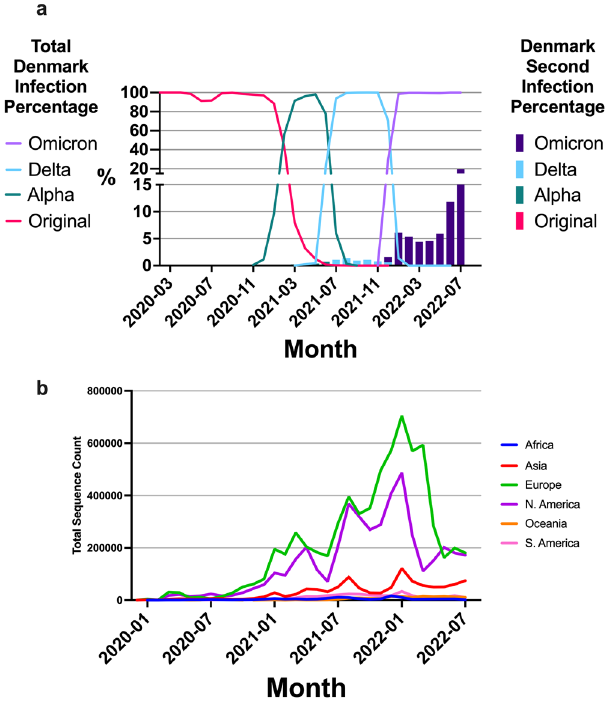
Fig. 2 Reinfection percentages and sequencing counts. a Denmark sequencing percentages overtime strati fi ed by variant represented as line plot with a bar plot overlay representing second infection percentages strati fi ed by variant that include NGS and rtPCR data. b Worldwide sequencing counts strati fi ed by continent over a period of one-month intervals. The data is also shown as percentage of cases sequenced over periods of one month in supplementary fi gure 2.